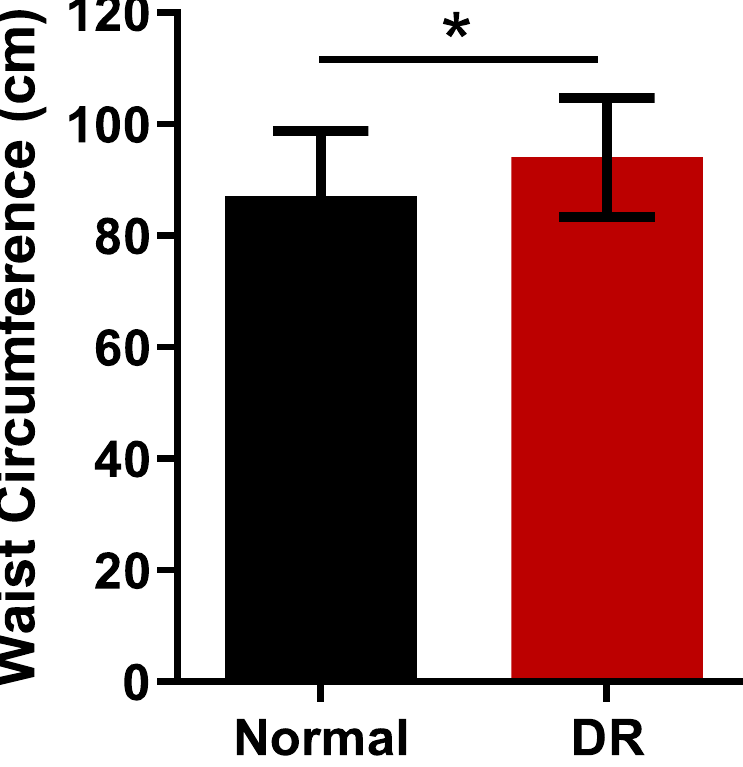
Figure 1. Waist circumferences between the normal and patients with DR. The data were com- pared using Student’s t-test and differences were considered significant when, * for p <